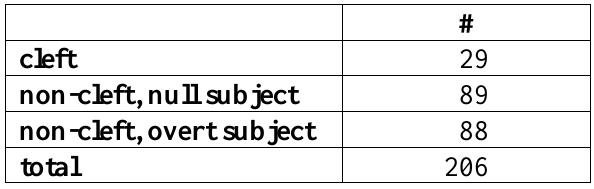
Table (3): Kinds of direct wh